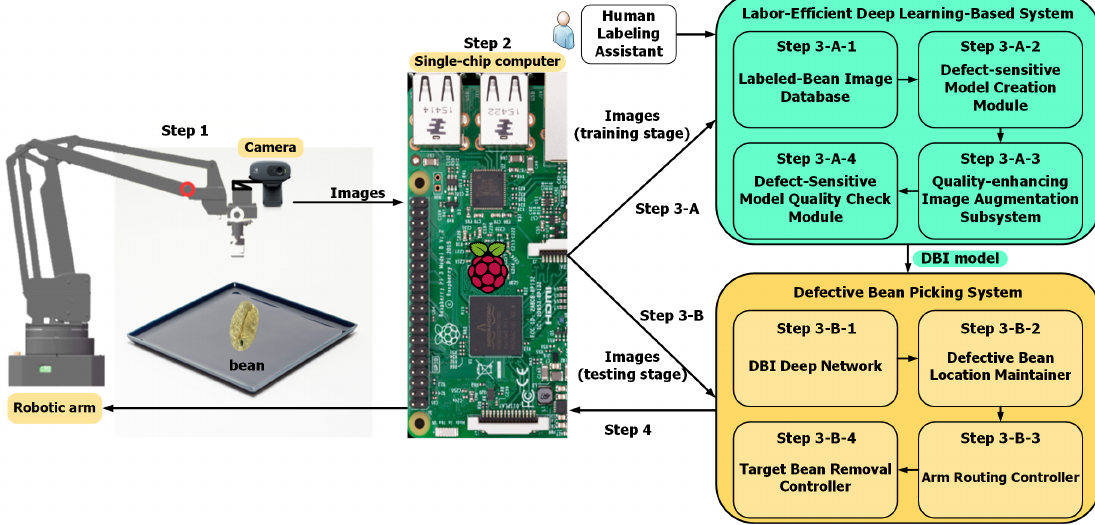
Figure 3. Illustration of defective bean removal with a robotic